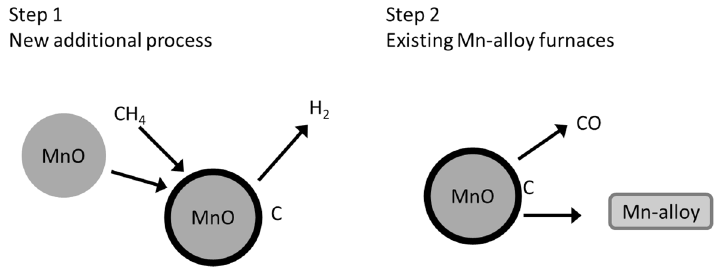
Figure 1. Principle sketch of the idea behind the current work. A two-step process is imagined. Step 1 is a new process: the deposition of carbon on MnO from methane, with hydrogen as a by-product. Step two is to use the produced composites in existing furnaces, in a process very similar to